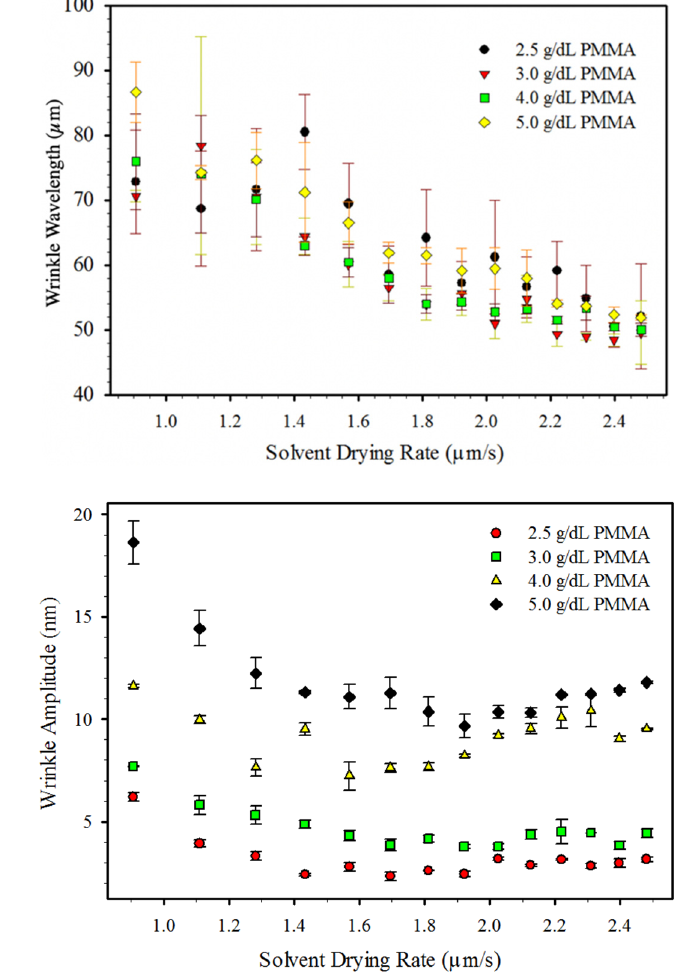
Figure 8. PMMA surface wrinkle wavelength ( A ) and wrinkle amplitude ( B ) as a function of solvent drying rate. Films were cast using 2.5, 3.0, 4.0, and 5.0 g/dL solutions spun at speeds from 400 to 3000 RPM. The error bars represent the standard deviation of four different ACL and RMS roughness measurements taken at incremental distances of 3.75, 7.50, 11.25, and 15.00 mm away from the spinning center.